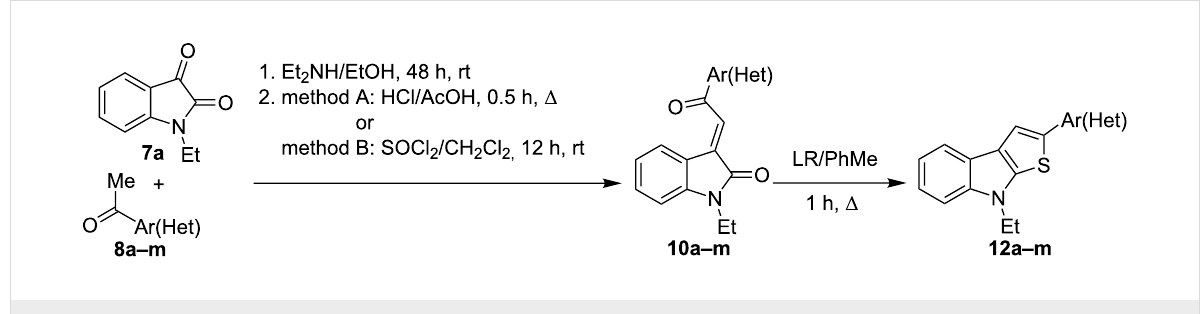
Scheme 4: Two-step synthesis of 2-(hetero)aryl substituted thieno[2,3- b ]indoles 12 .